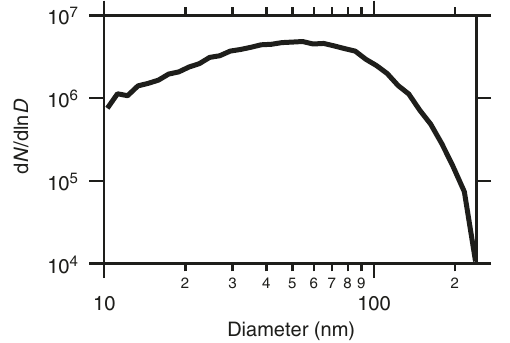
Fig. 6 DMPS size distributions of tungsten blue oxide particles measured in helium. The shape of the curve does not follow a log-normal distribution, which indicates that the particles are aggregated. Several parameters can be derived from the distribution. The mode of the distribution is at D mode = 54.5 nm and the mean (mobility) diameter is 〈 D 〉 = 52.5 nm. The geometric standard deviation result in σ geom = 1.88 and the total concentration in N = 3.47 × 10 6 cm − 3 conc